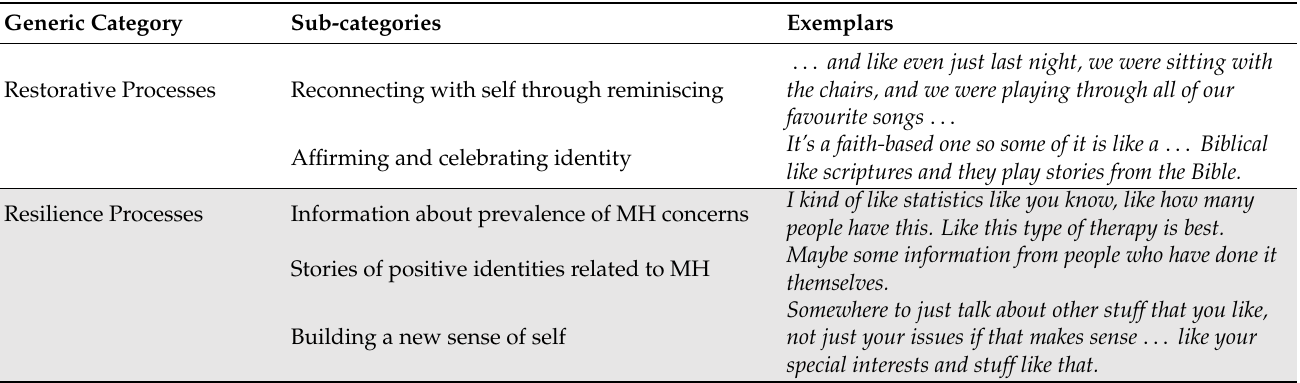
Table 7. Exemplars and categories related to identity recovery